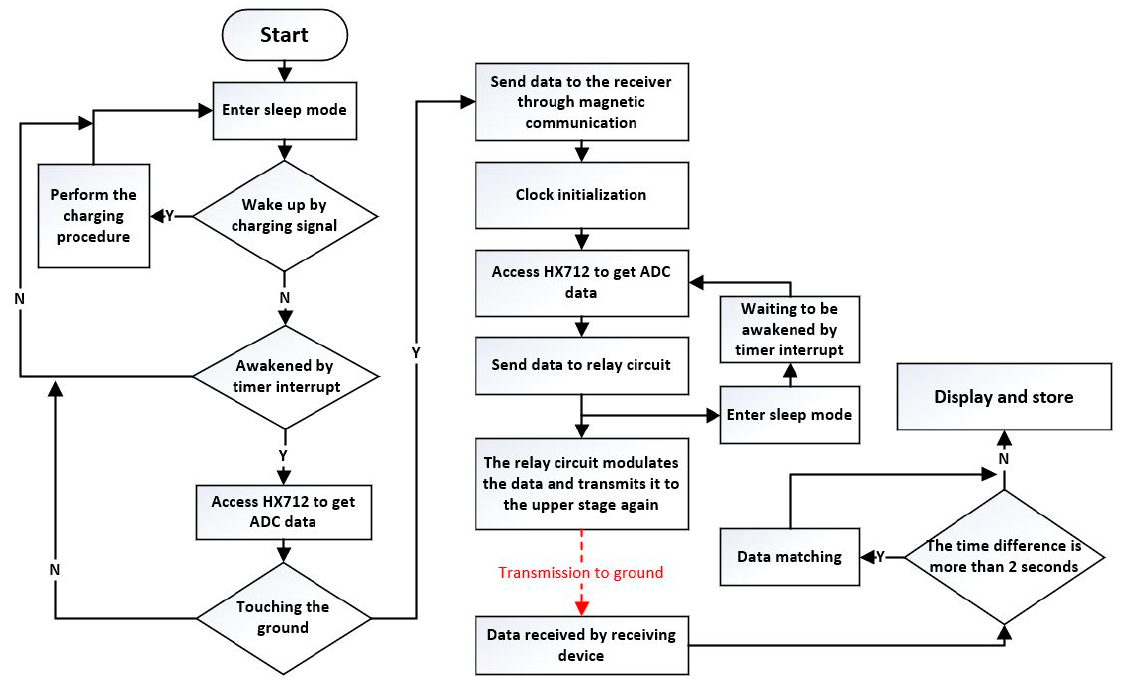
Figure 20. Program flow